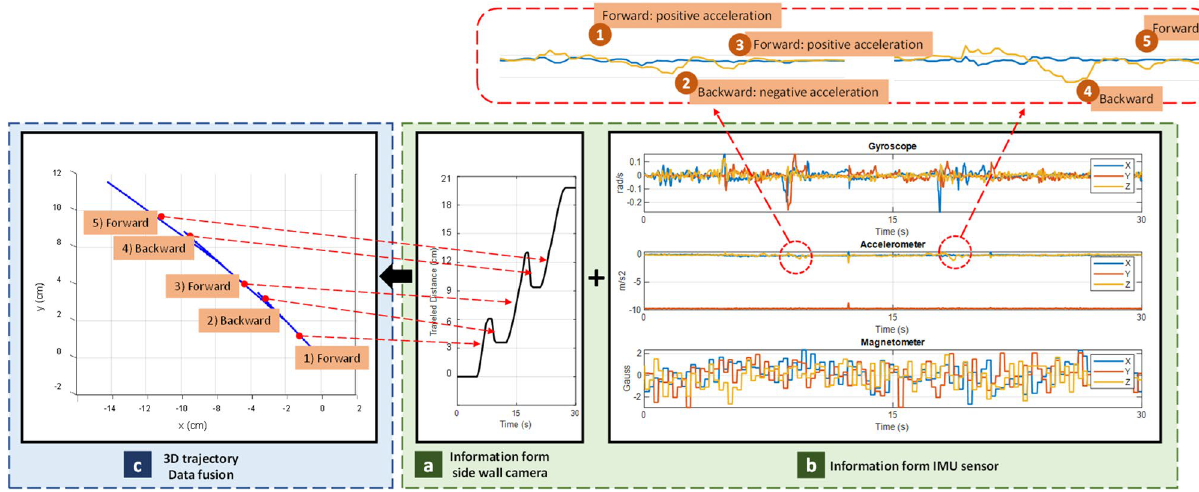
Figure 12. Results of Peristalsis motion analysis.